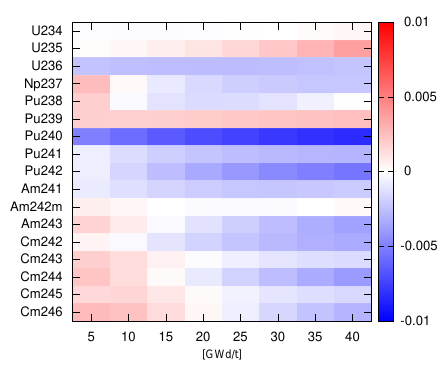
Figure 13. Weights of individual mockup parameters in the fic- titious mockup parameters for k